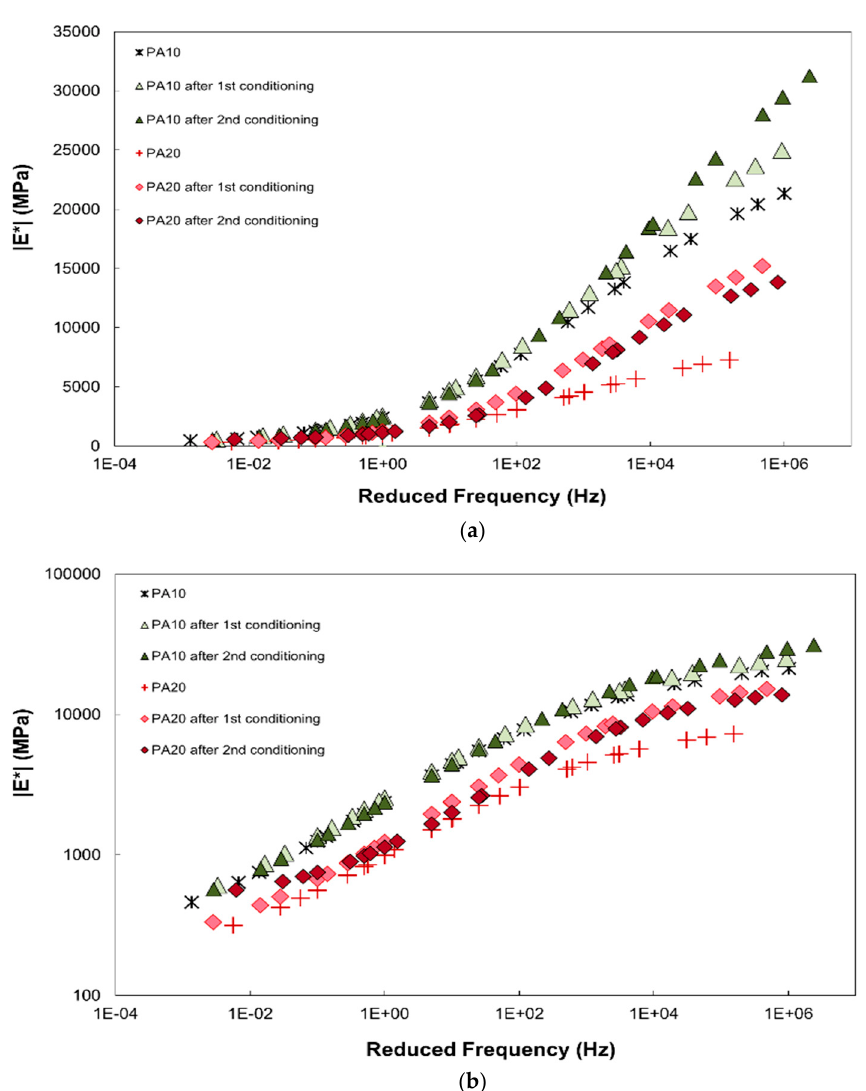
Figure 6. Dynamic Modulus master curves of unconditioned and conditioned specimens in: ( a ) semi-log scale; ( b ) log-log scale.